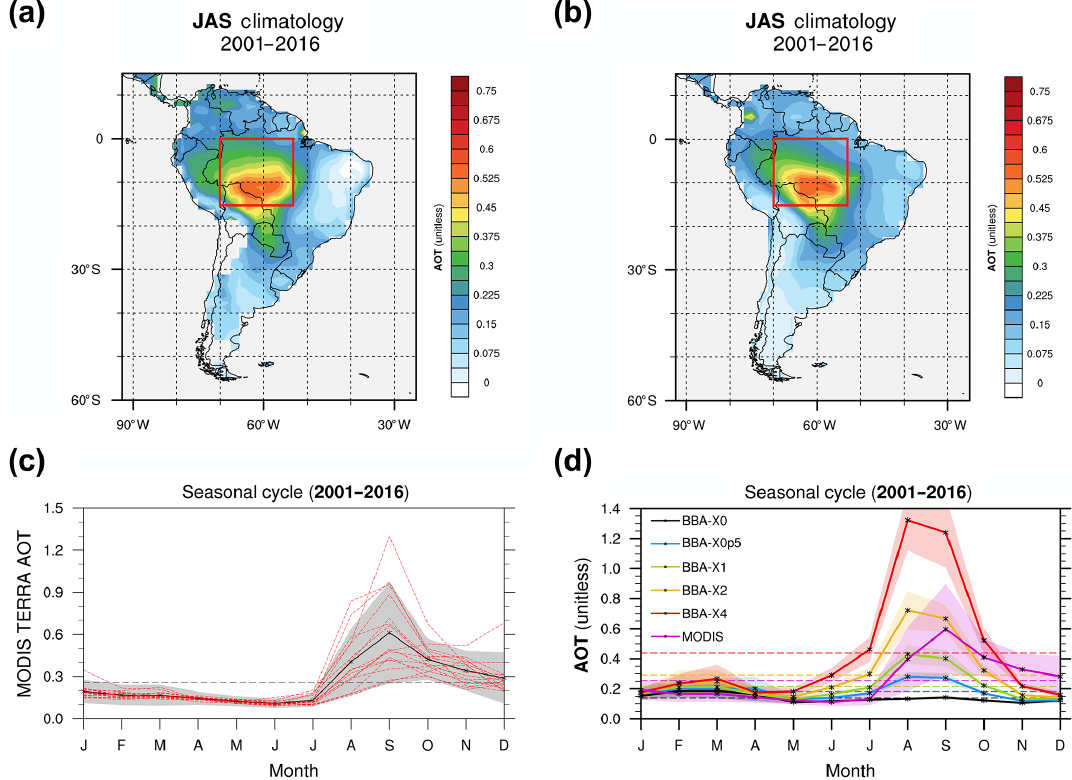
Figure 2. Multi-annual mean for the June–July–August season (JAS) of the aerosol optical thickness (AOT) at 550nm ( a, b ) and the seasonal cycle ( c, d ) of the AOT calculated over the domain highlighted in red for the MODIS Terra retrieval ( a, c ) and the HadGEM2-ES model ( b, d ). The MODIS seasonal cycle ( c ) shows the multi-year (2001–2016) mean with the black line, and the individual years are overlaid with red dashed lines. The seasonal cycle for HadGEM2-ES ( d ) shows the 30-year mean for the five experiments with varying biomass burning emissions (see text, Sect.